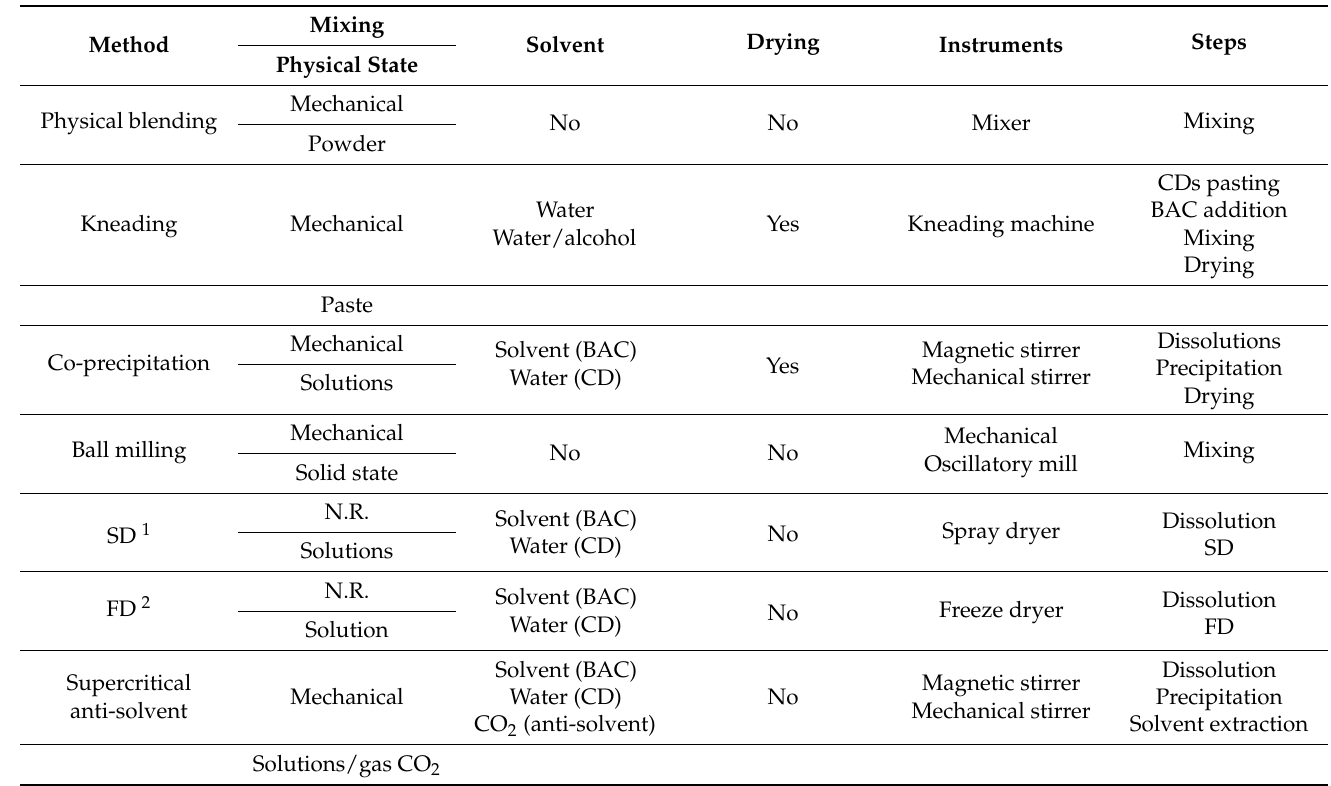
Table 10. Most common methods for preparing